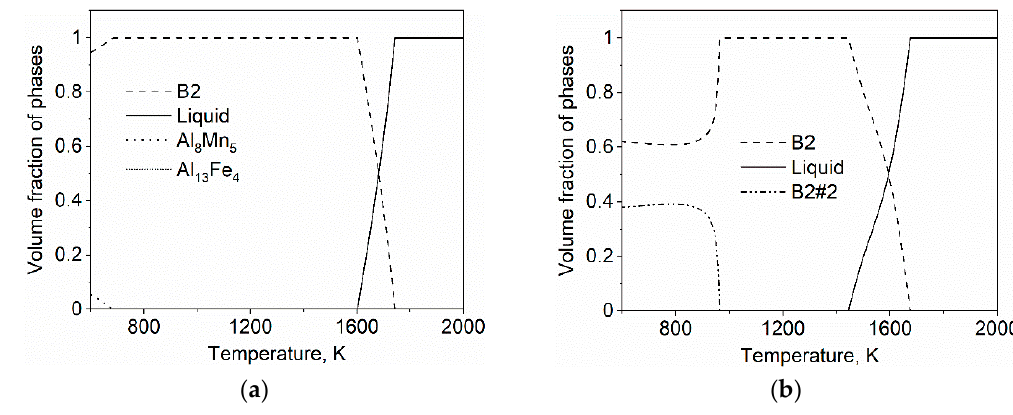
Figure 3. Calculated phase fraction plot for ( a ) quinary Al(CoFeMnNi); ( b ) senary Al(CoCuFeMnNi).